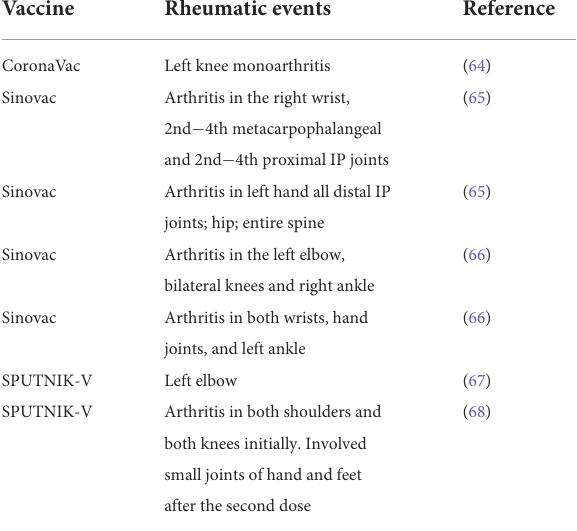
TABLE 1 Post-vaccination inflammatory